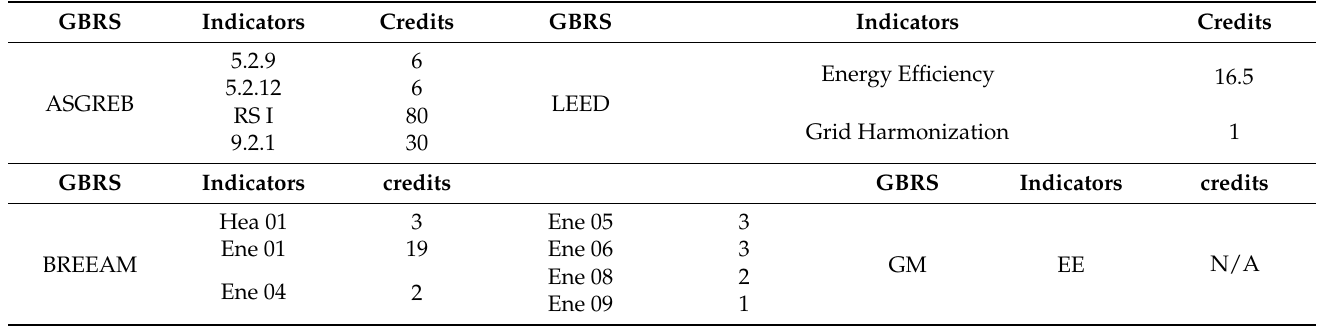
Table 8. Energy scope CO 2 -related indicators analysis.